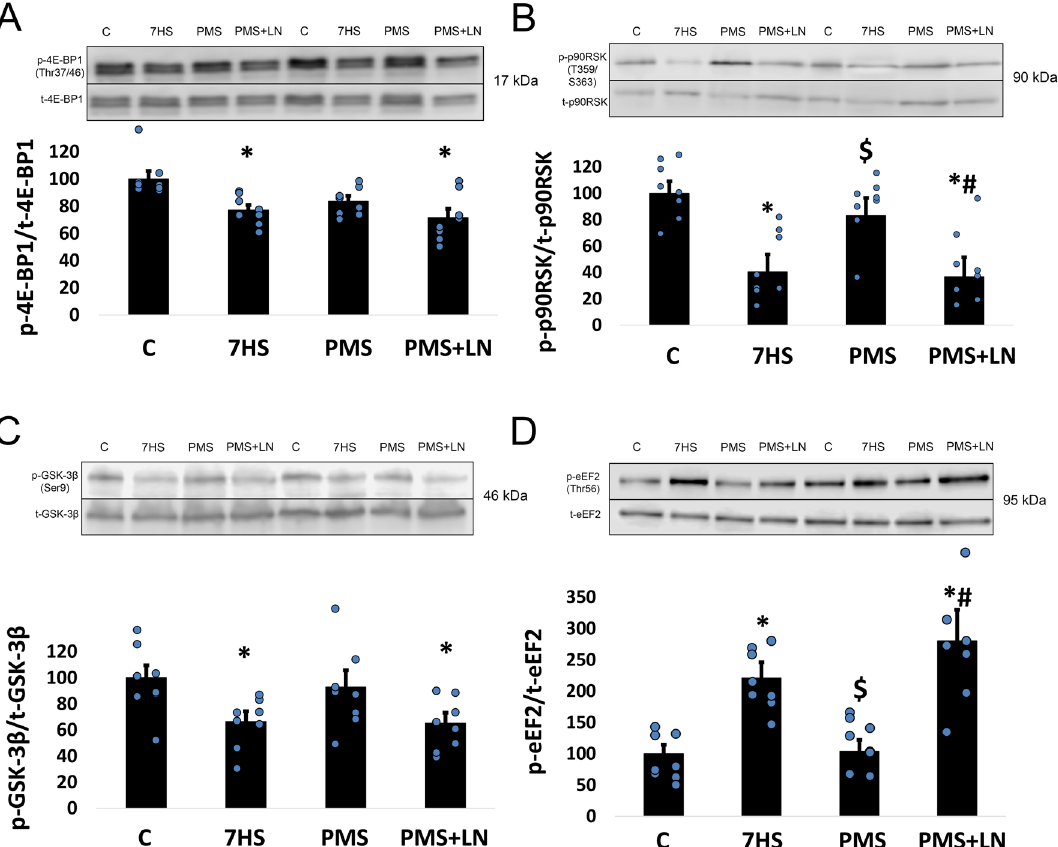
Figure 4. ( A ) Quantification of phospho-4E-BP1 (Thr37/46)/total 4E-BP1 ratio. ( B ) Quantification of phospho-p90RSK (Ser380)/total p90RSK ratio. ( C ) Quantification of phospho-GSK-3β (Ser9)/total GSK-3β ratio. ( D ) Quantification of phospho-eEF2 (Thr56)/total eEF2 ratio. 7-days hindlimb suspended group with plantar mechanical stimulation (PMS); 7-day hindlimb suspended group with plantar mechanical stimulation + L-NAME injection (PMS + LN). Data shown as % of control group. *Significant difference from control group. # Significant difference from PMS. $ Significant difference from 7HS ( p < 0.05). Blue dots correspond to the number of samples. The quantification of the proteins was performed using Image Studio Digits 4.0.21 software (https:// www. licor. com/ bio/ image-